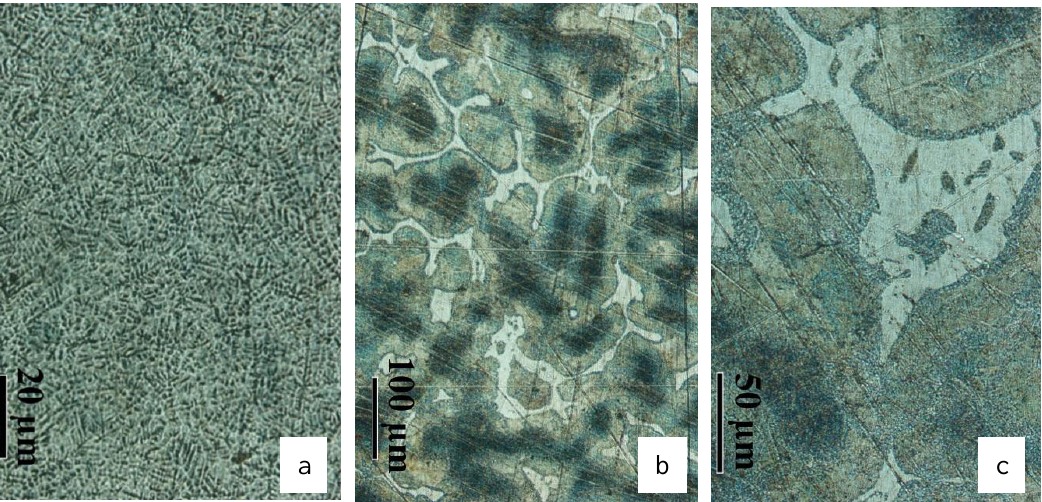
Figure 2. Optical Microstructures for the ZnAl22 alloy cast in: ( a ) steel die; ( b ) ceramic refractory die; ( c ) ceramic refractory die cooled in the furnace.